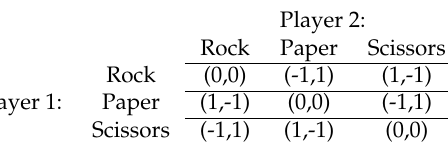
Figure 3. Payoffs for a single throw of